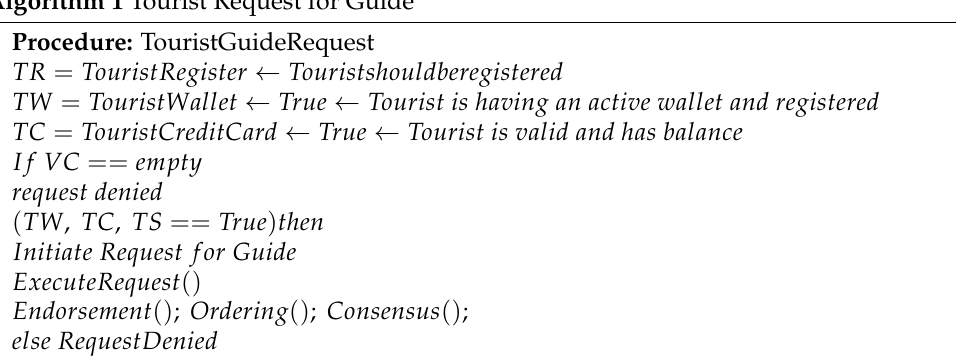
Algorithm 1 Tourist Request for